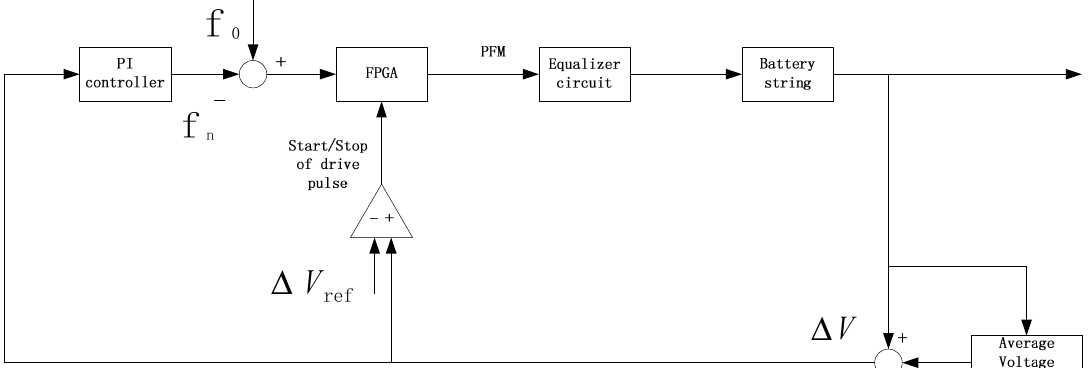
Figure 9. PI controller block